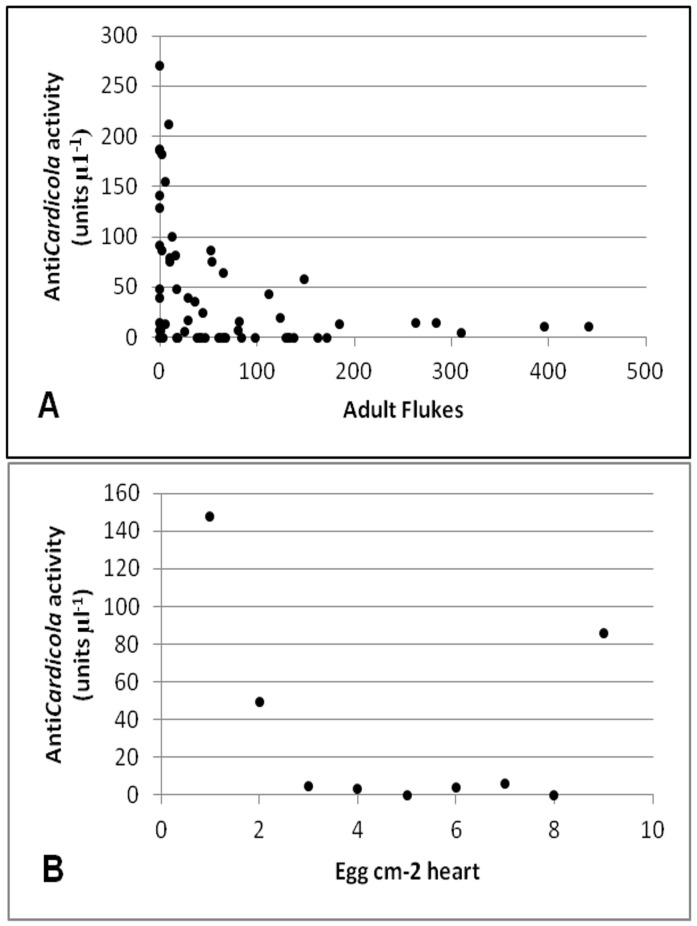
Correlations between AntiCardicola activity in T. maccoyii serum and C. forsteri: (A) Cohort2008, Spearman’s rho = −0.330, df = 62, p = 0.01 (B) Cohort2010 at week 9, Spearman’s rho = 0.767, df = 10, p = 0.021.